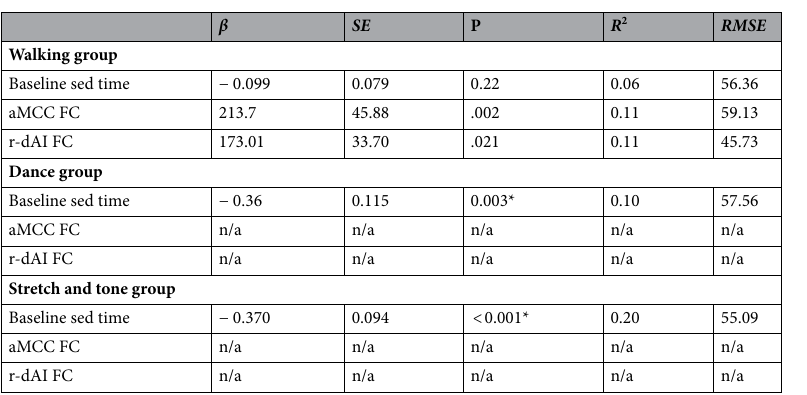
Table 2. Prediction of change in time sent sedentary. All models are performed using leave-one-out cross validation. RMSE root mean square error and represents the differences between the observed and predicted outcomes (the lower the value the better the prediction). All significant models survive multiple comparisons using false discovery rate (supplementary material 4). Statistical significance of the prediction models was assessed via 1000 nonparametric permutations and the p-value of the permutation tests were calculated as the proportion of sampled permutations that are greater or equal to the true prediction